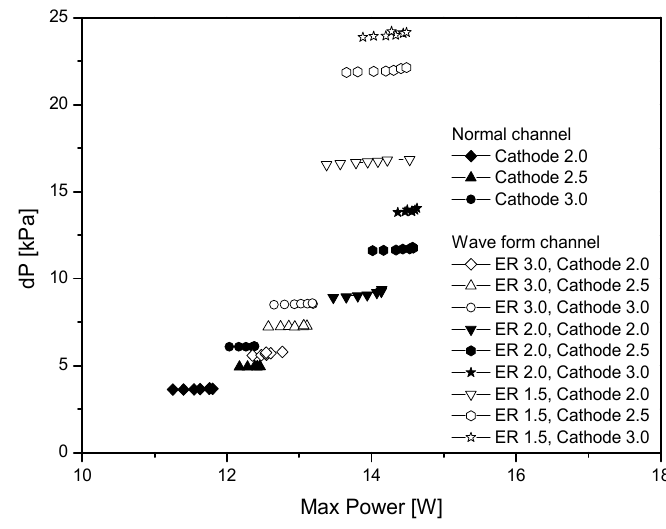
Figure 13. Pressure difference of the normal channel and wave form channel with varied ER, according to variation in the cathode stoichiometry.